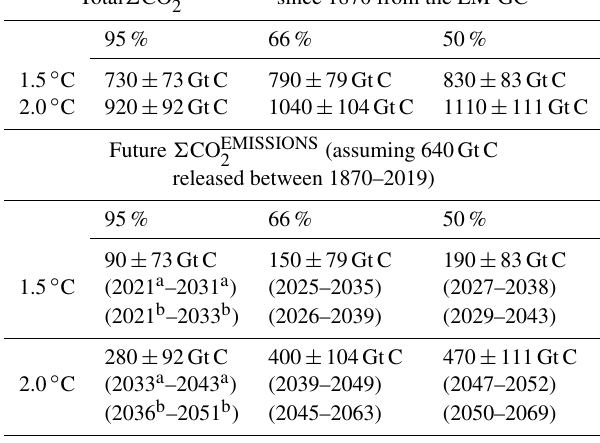
Table 2. Total cumulative and future carbon emissions that will lead to crossing the Paris temperature thresholds based on the EM-GC trained using the HadCRUT5 (cid:49)T record. Estimates of (cid:54) CO EMISSIONS that would cause global warming to stay below 2 indicated thresholds for 95%, 66%, and 50% probabilities are rounded to the nearest 10GtC. The values in the top half of the table are the estimates of total cumulative carbon emissions that will lead to crossing the Paris Agreement thresholds with the 10% uncertainty for how atmospheric CO 2 responds to prescribed car- bon emissions (see text) included. The values in the bottom half of the table are the estimates of future cumulative carbon emissions after 2019 that will lead to crossing the Paris Agreement thresholds with the same 10% uncertainty. The range of years given repre- sents when the Paris Agreement thresholds will be passed based on the rate of emissions from SSP5-8.5 or continuing the 2019 rate of emissions of 11.7GtCyr − 1 (Friedlingstein et al., 2019). since 1870 from the